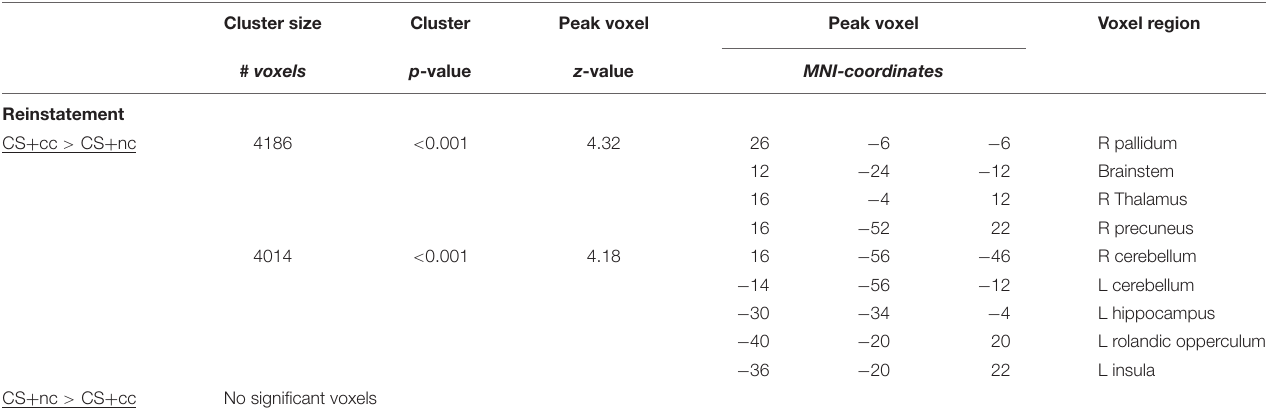
TABLE 2 | Differences in ventral striatal connectivity following reward